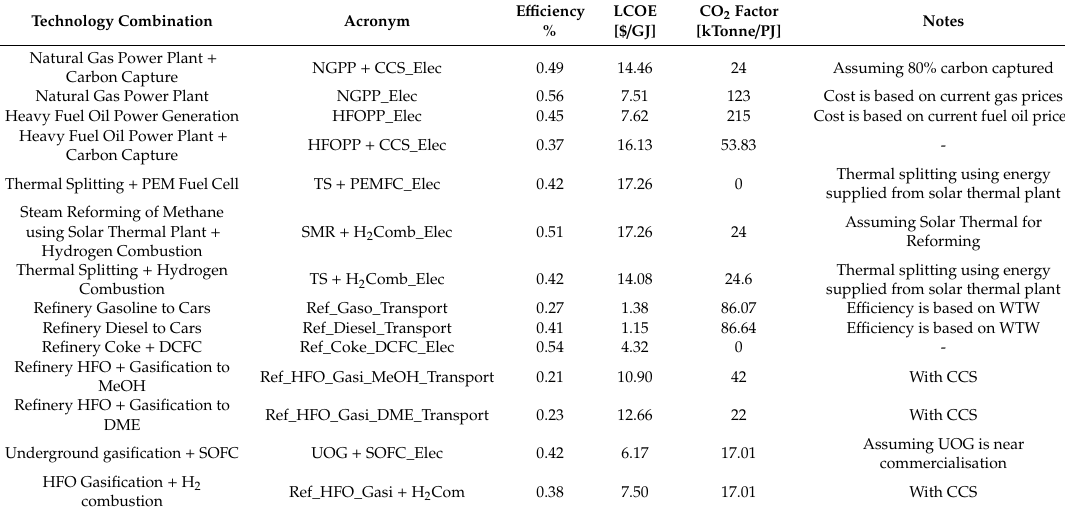
Table 2. Techno-economic Data [17,31,34–37].